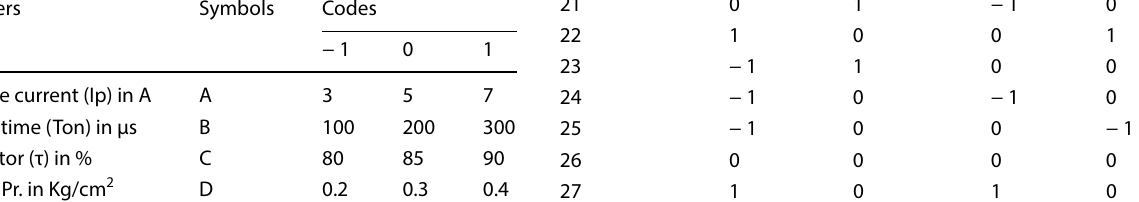
Table 1 Factors and their levels Parameters Symbols Codes